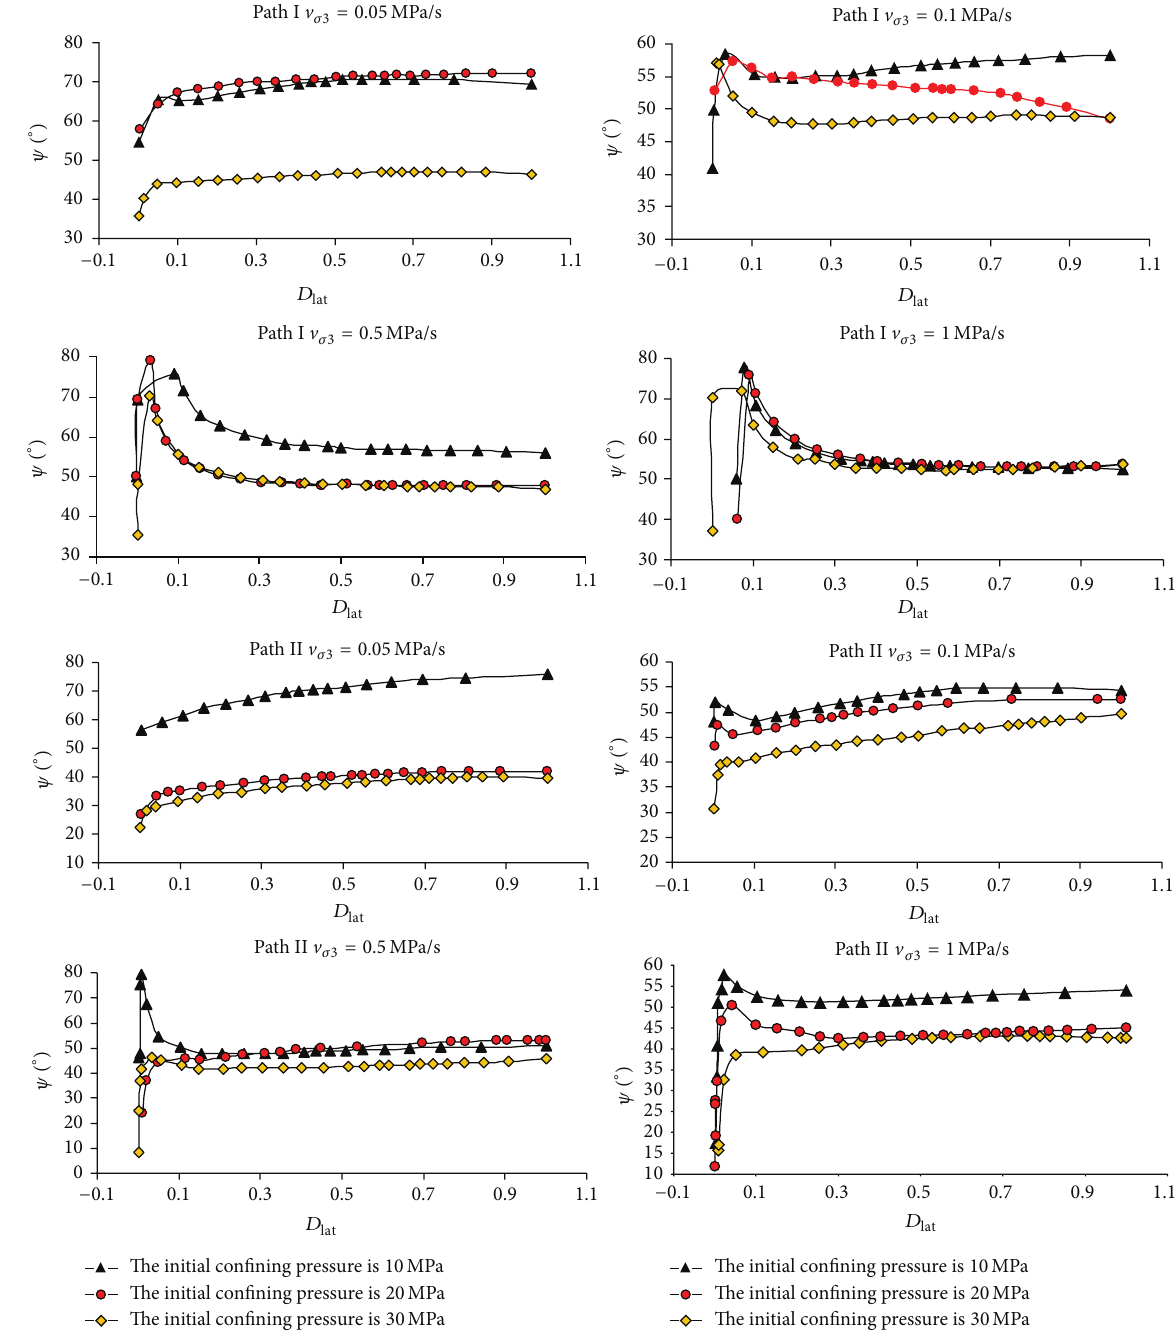
Figure 3: The evolution of dilatancy angle with variation of lateral strain